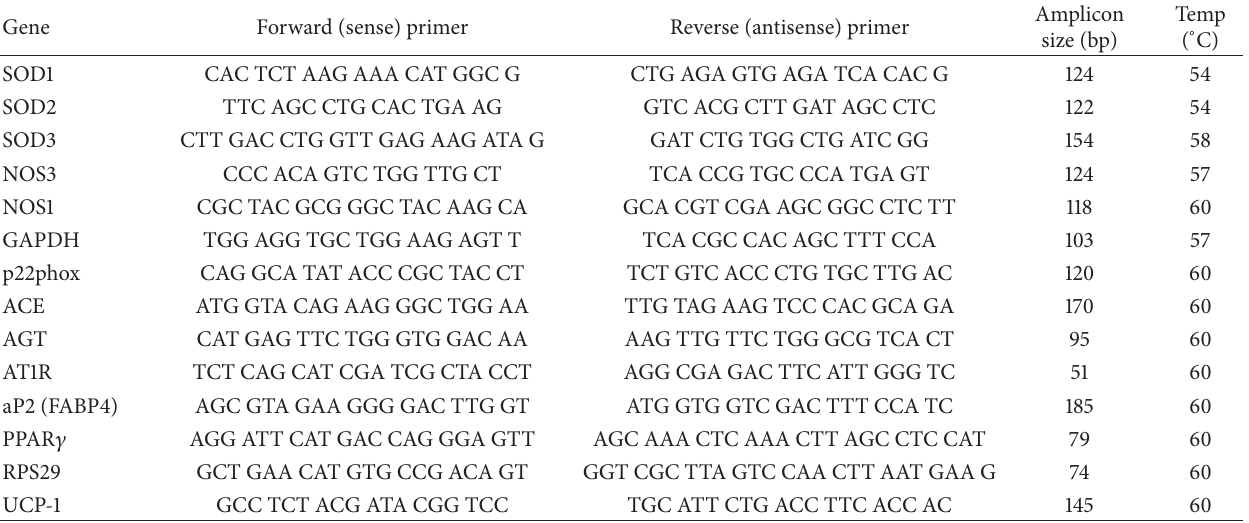
Table 1: Primer pairs used for amplification of selected